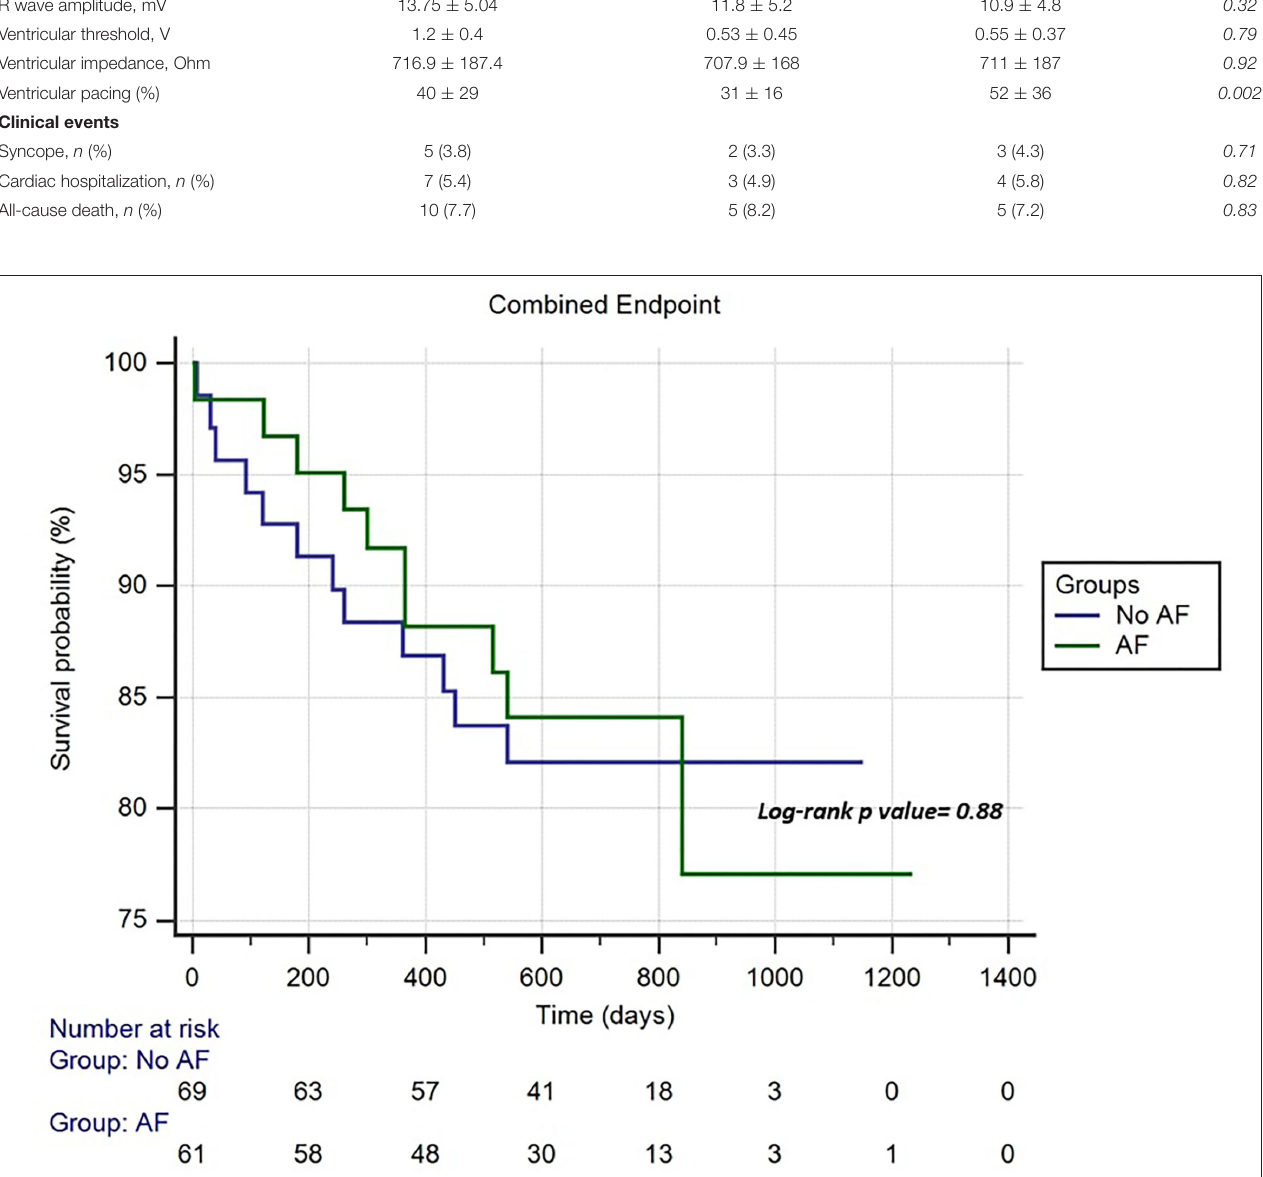
FIGURE 2 | Cumulative risk of combined endpoint (syncope, cardiac hospitalization, and mortality) between the atrial fibrillation (AF) and non-AF